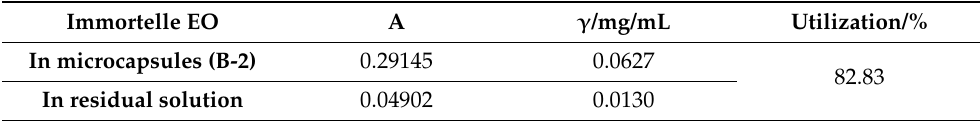
Table 4. Utilization of immortelle EO in microcapsules synthesis (B-2). Immortelle EO A γ /mg/mL In microcapsules